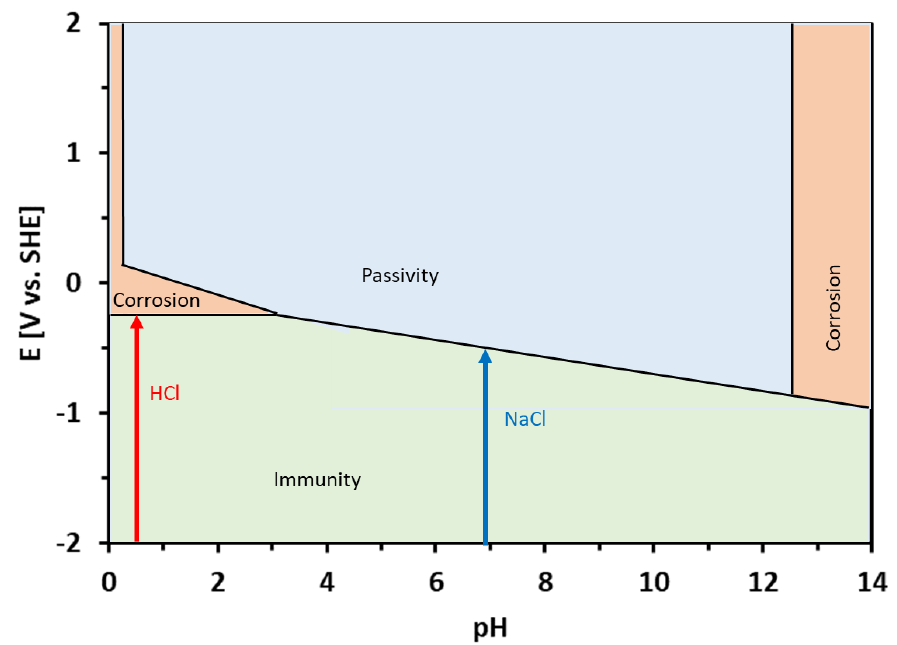
Figure 8. Theoretical equilibrium E-pH diagram of the Zn–Sn–H 2 O system, redrawn from ref. [49]. The pH values of the HCl and NaCl solutions are depicted by arrows.